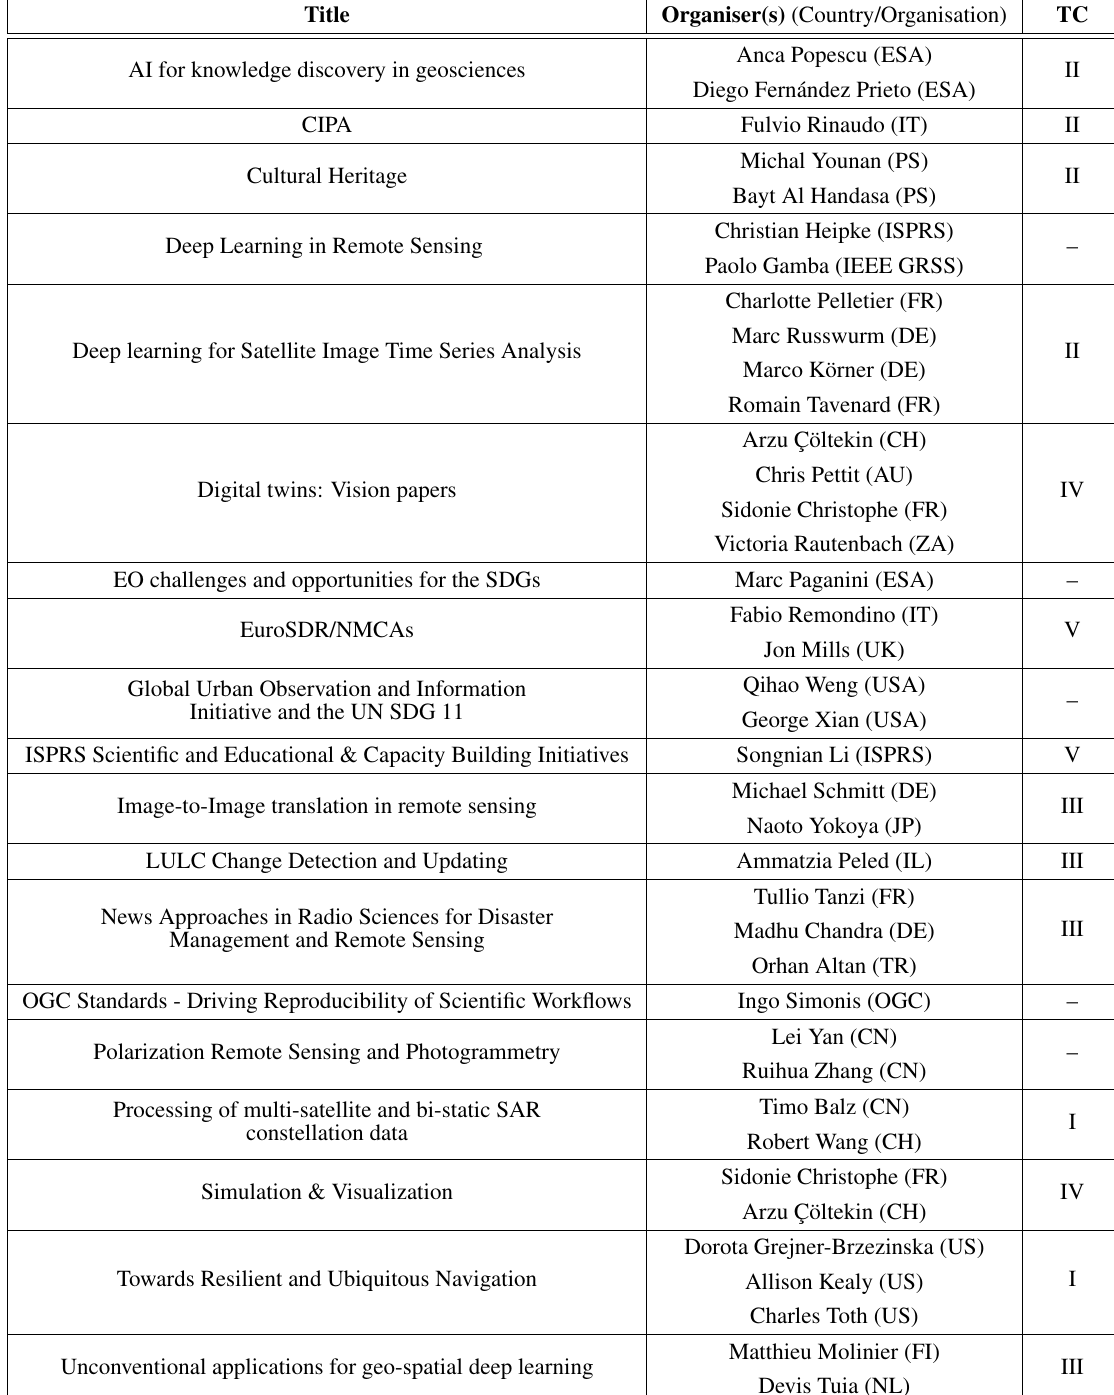
Table 1. Thematic Sessions of the 2021 edition of the ISPRS Congress. ”–” means no papers were published in the proceedings.